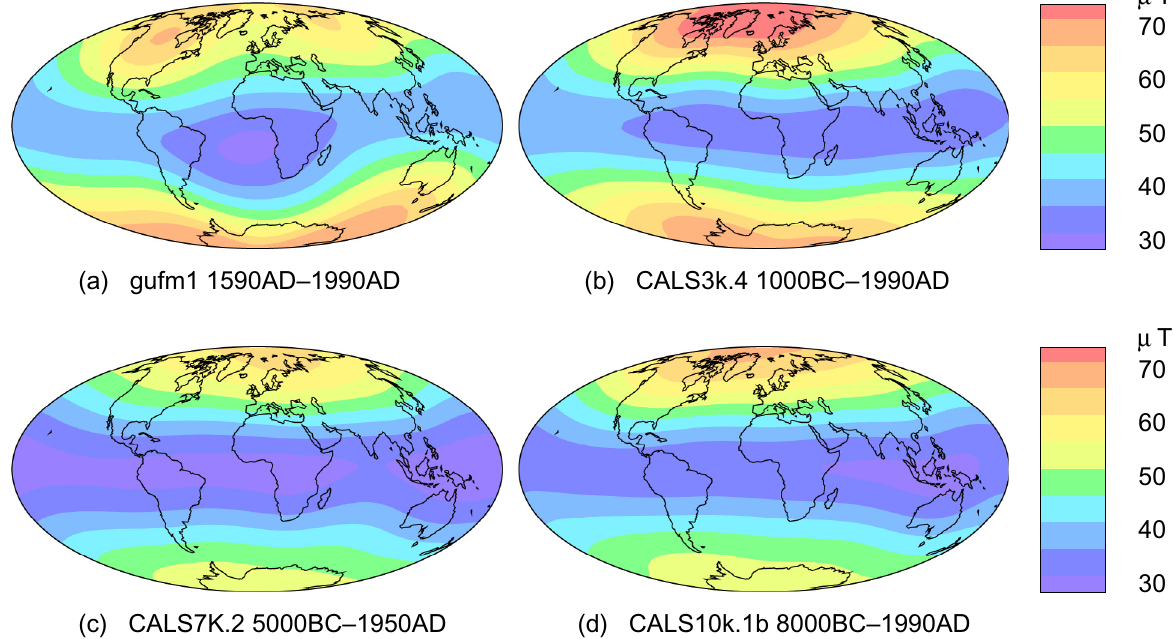
Fig. 2. Field intensity distribution at the Earth surface predicted by spherical harmonic field models averaged over 400 years (a) model gufm1, 3 kyrs (b) model CALS3k.4, 7 kyrs (c), outdated model CALS7K.2 and 10 kyrs (d) model CALS10k.1b.